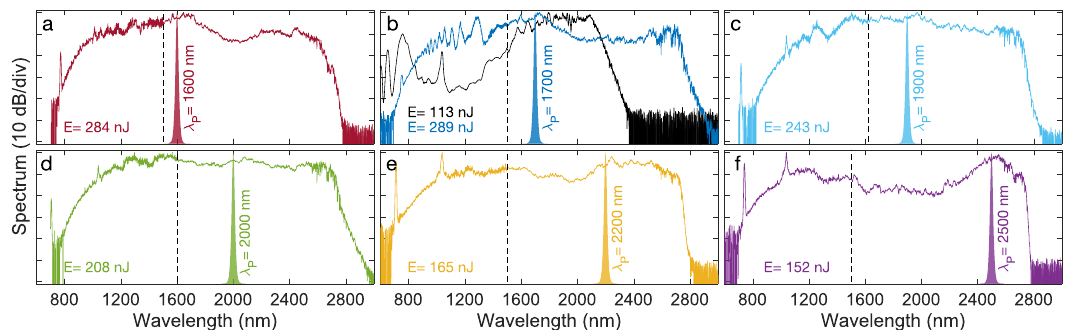
Fig. 6 Experimentally measured supercontinuum spectra in 20 cm of the PBG fi ber as a function of pump wavelength λ p . a λ p = 1600 nm, b λ p = 1700 nm, c λ p = 1900 nm, d λ p = 2000nm, e λ p = 2200 nm, and f λ p = 2500 nm. The output pulse energy E is indicated in each subplot. The OPA spectrum is also shown for each pump wavelength and the dashed line marks the spectral regions measured using different OSAs (see Methods). The spectral peaks at wavelengths of 750 nm and 1040 nm are residues from the OPA and OPA pump laser, respectively. The black solid line in b shows the experimental spectrum obtained in a 20 cm GRIN silica fi ber using the same pump wavelength of 1700 nm and injected intensity (see